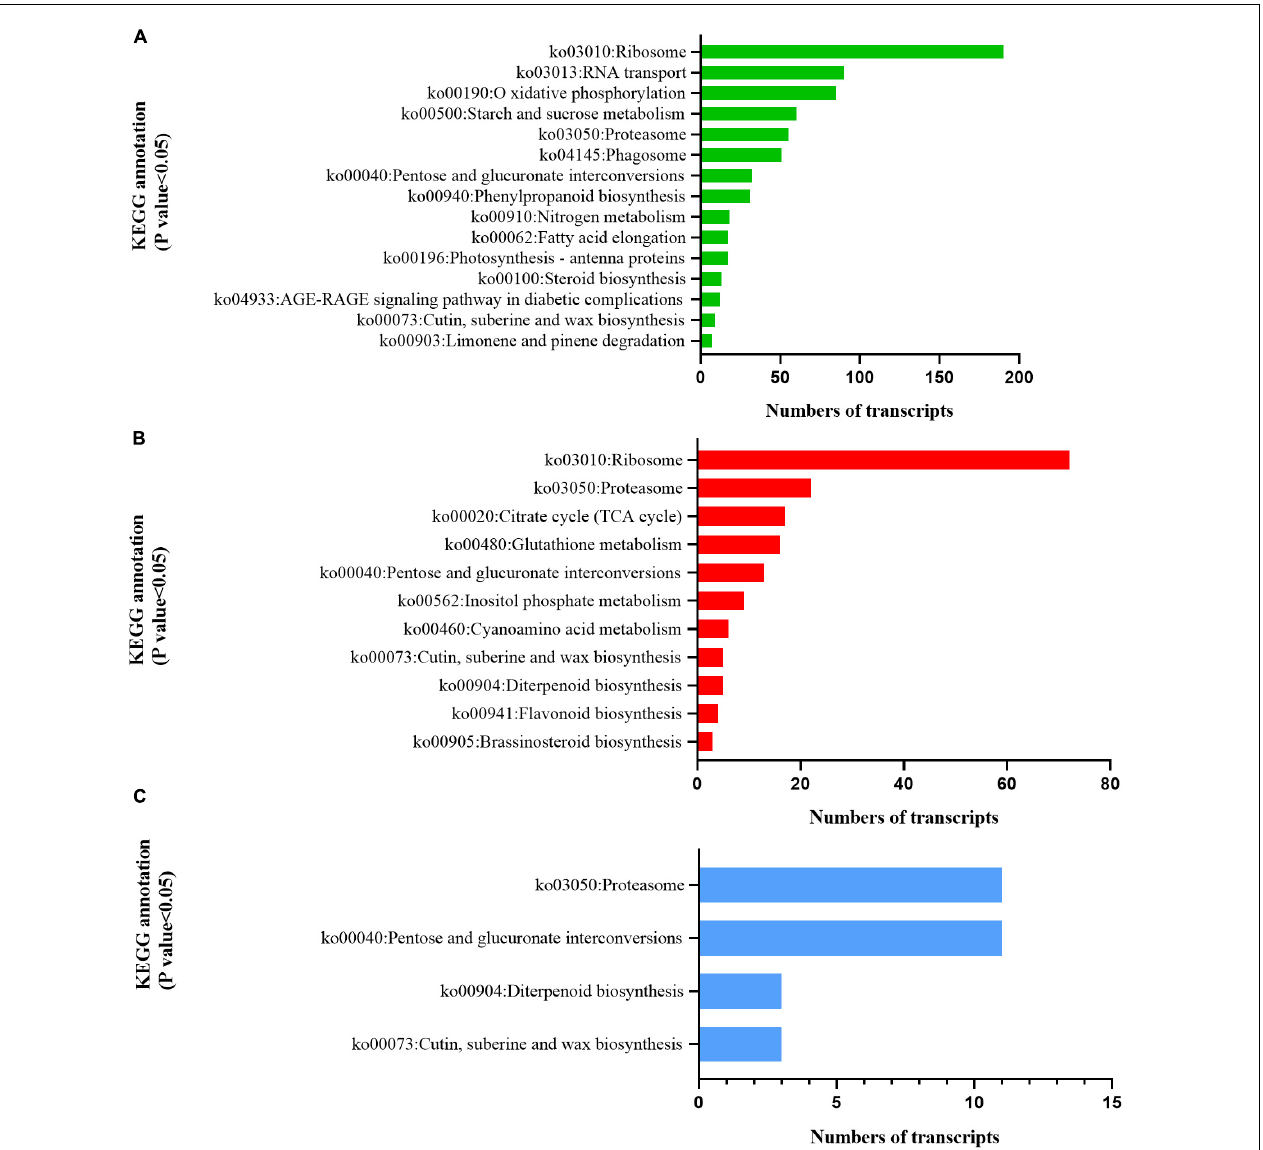
FIGURE 8 | Kyoto Encyclopedia of Genes and Genomes (KEGG) enrichment analysis of pathways involved in the response to enhanced UV-B radiation. (A) Mingui 1, (B) Mingui 2, (C) common pathways of two